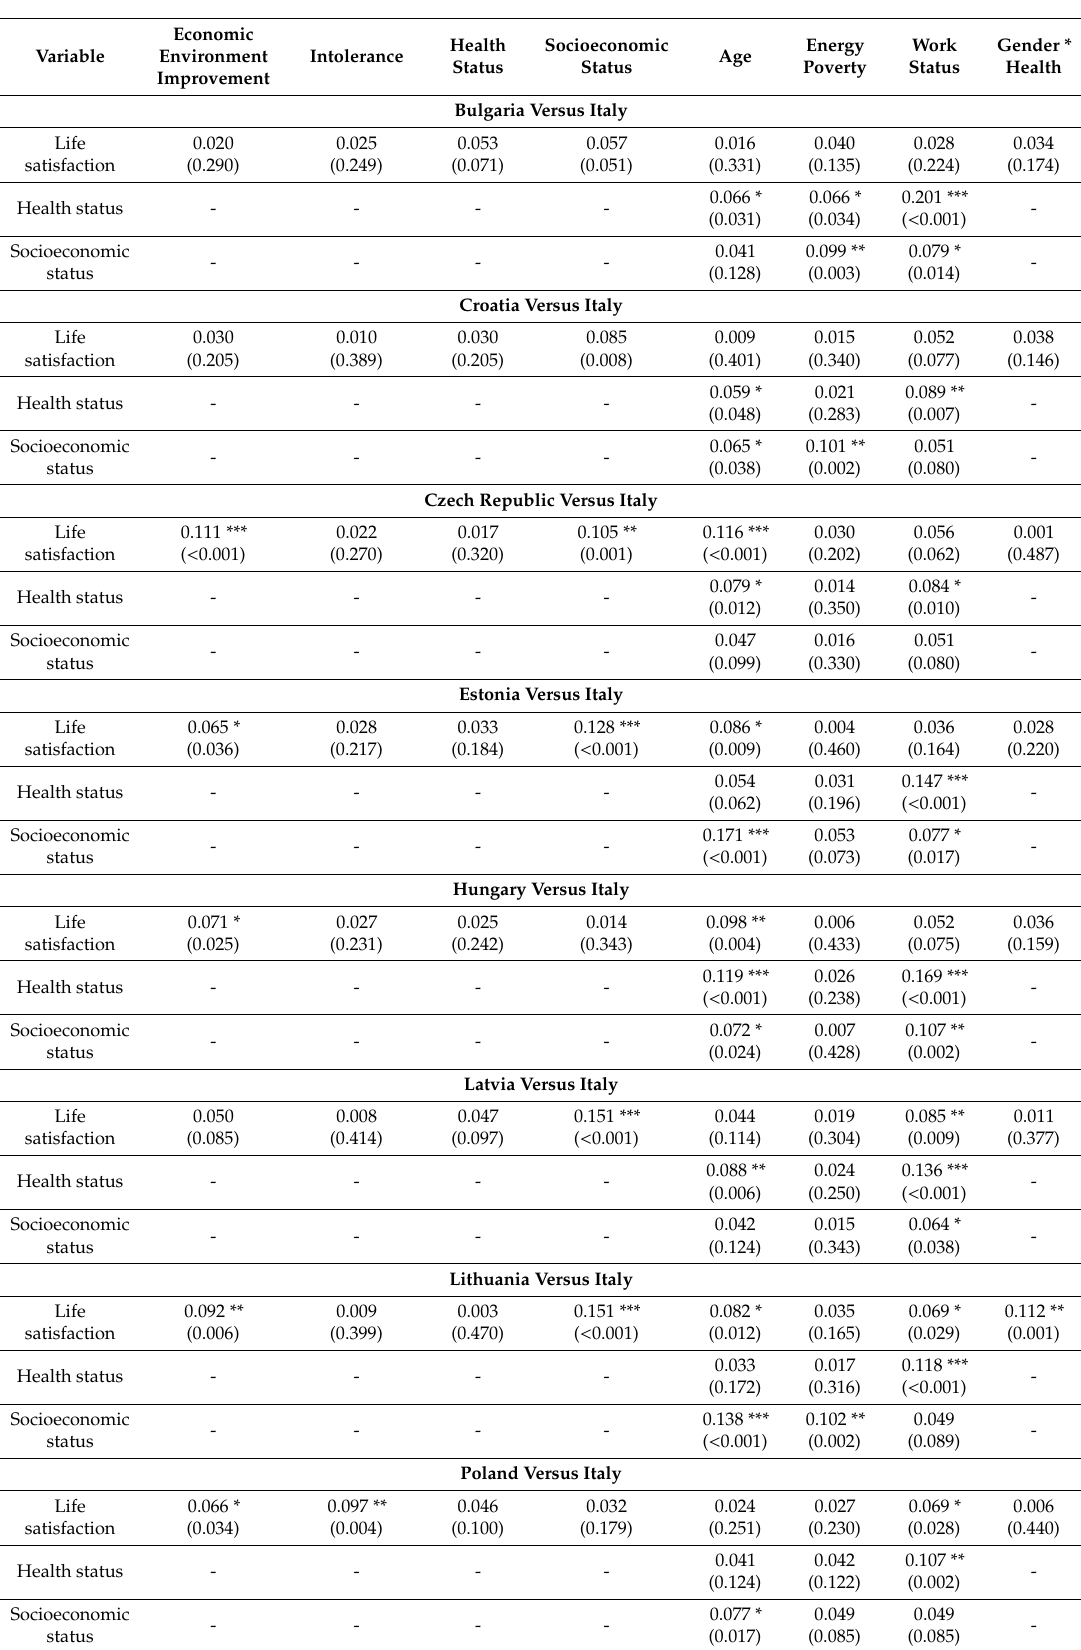
Table 6. Di ff erences across countries in the estimated path coe ffi